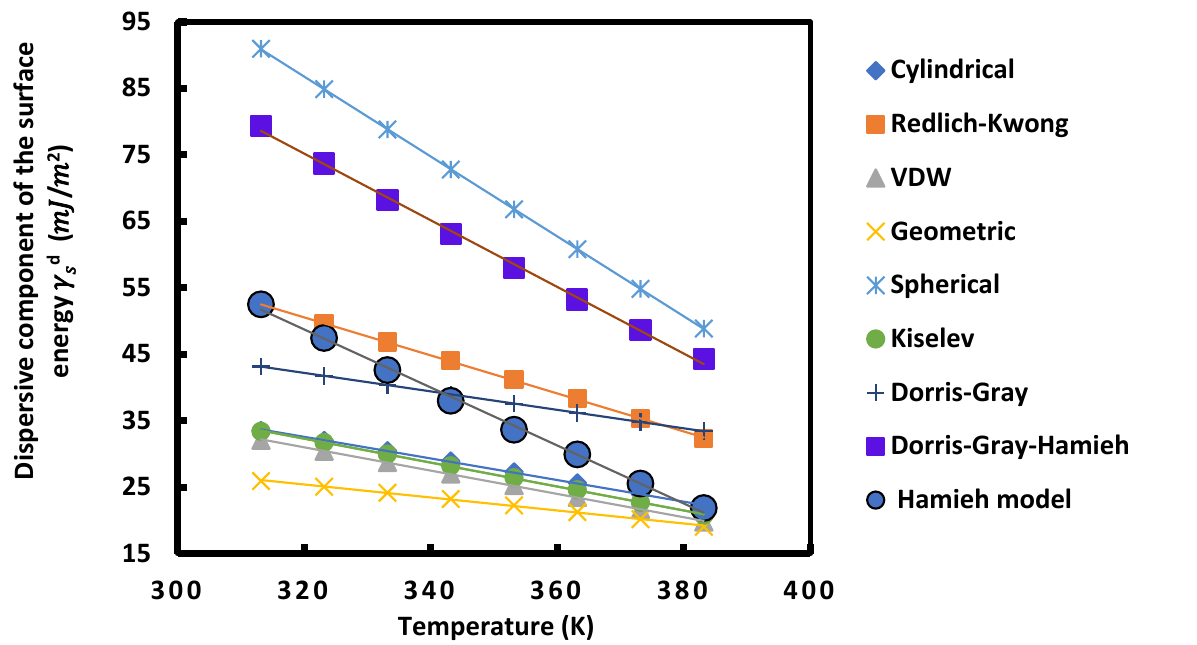
(cid:0) (cid:1) mJ/m 2 of UiO-66-AA as